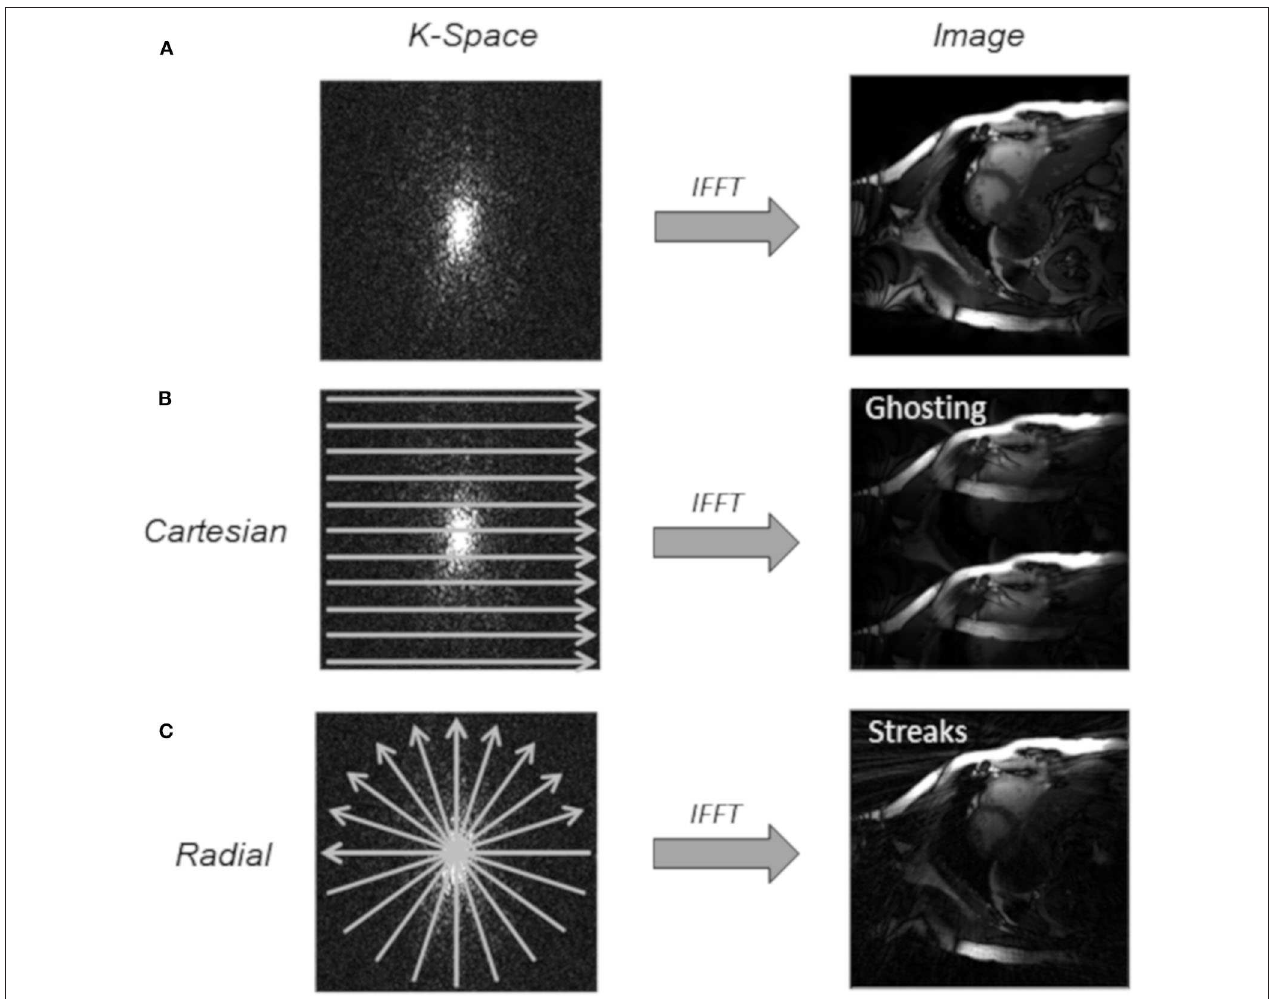
FIGURE 2 | Undersampling techniques used for cardiac imaging. (A) Fully sampled k-space. (B) Regular Cartesian undersampling (2-fold), which results in discrete aliasing artifacts in the reconstructed image with an inverse fast Fourier transform (IFFT). (C) Uniform radial undersampling (2-fold) leads to low-intensity streaking